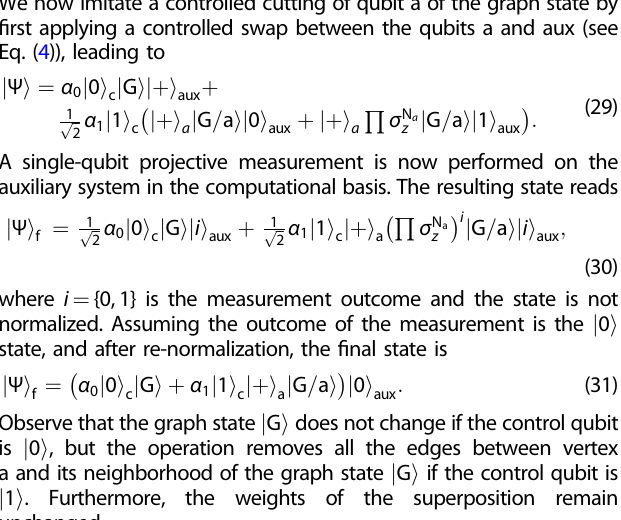
Algorithm 3 . Controlled cutting. Input: Graph state G.